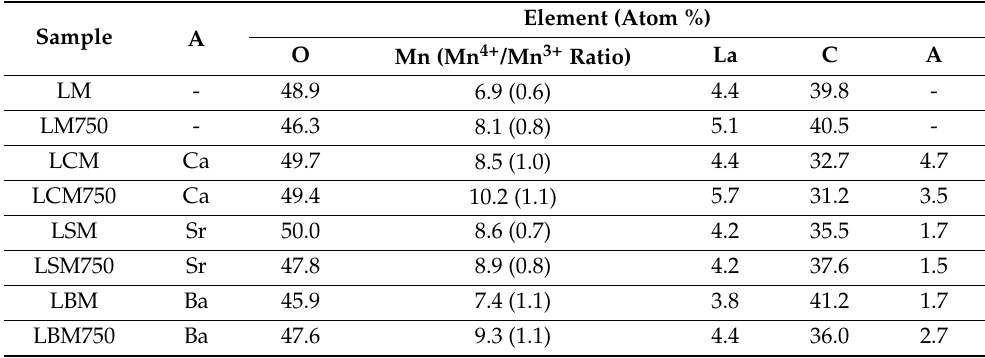
Table 5. Surface atomic concentrations (%) determined from the XPS survey spectra and Mn cations ratios for each sample, being A the dopant